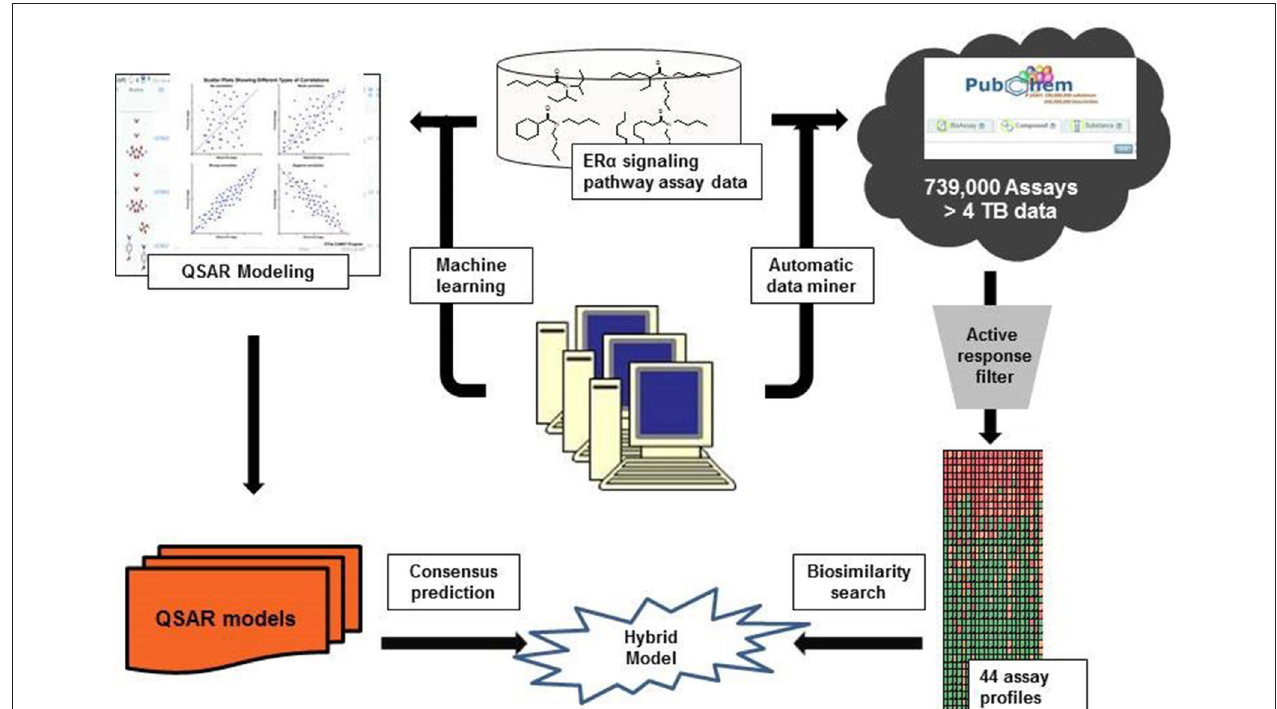
FIGURE 1 | The hybrid modeling